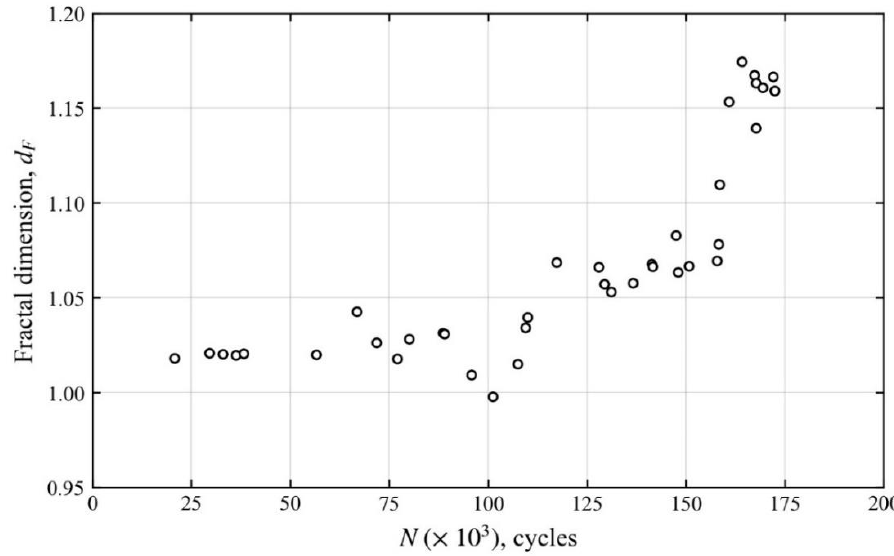
Figure 7. Variation of the local fractal dimension along the edge of a growing fatigue crack in the bell crank structure.